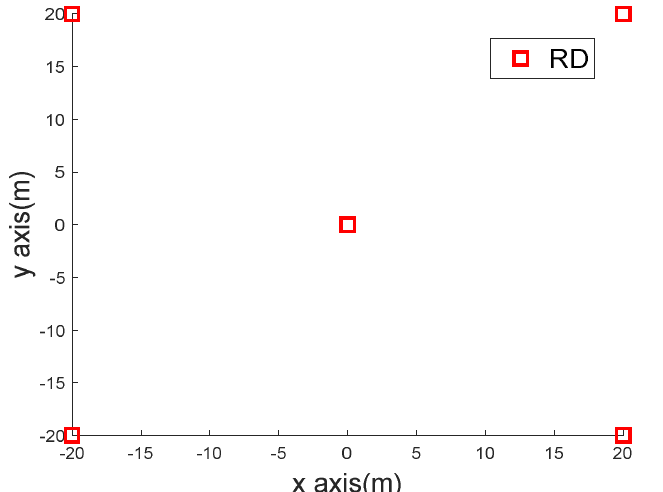
Figure 3. The topology diagram of the RN distribution.